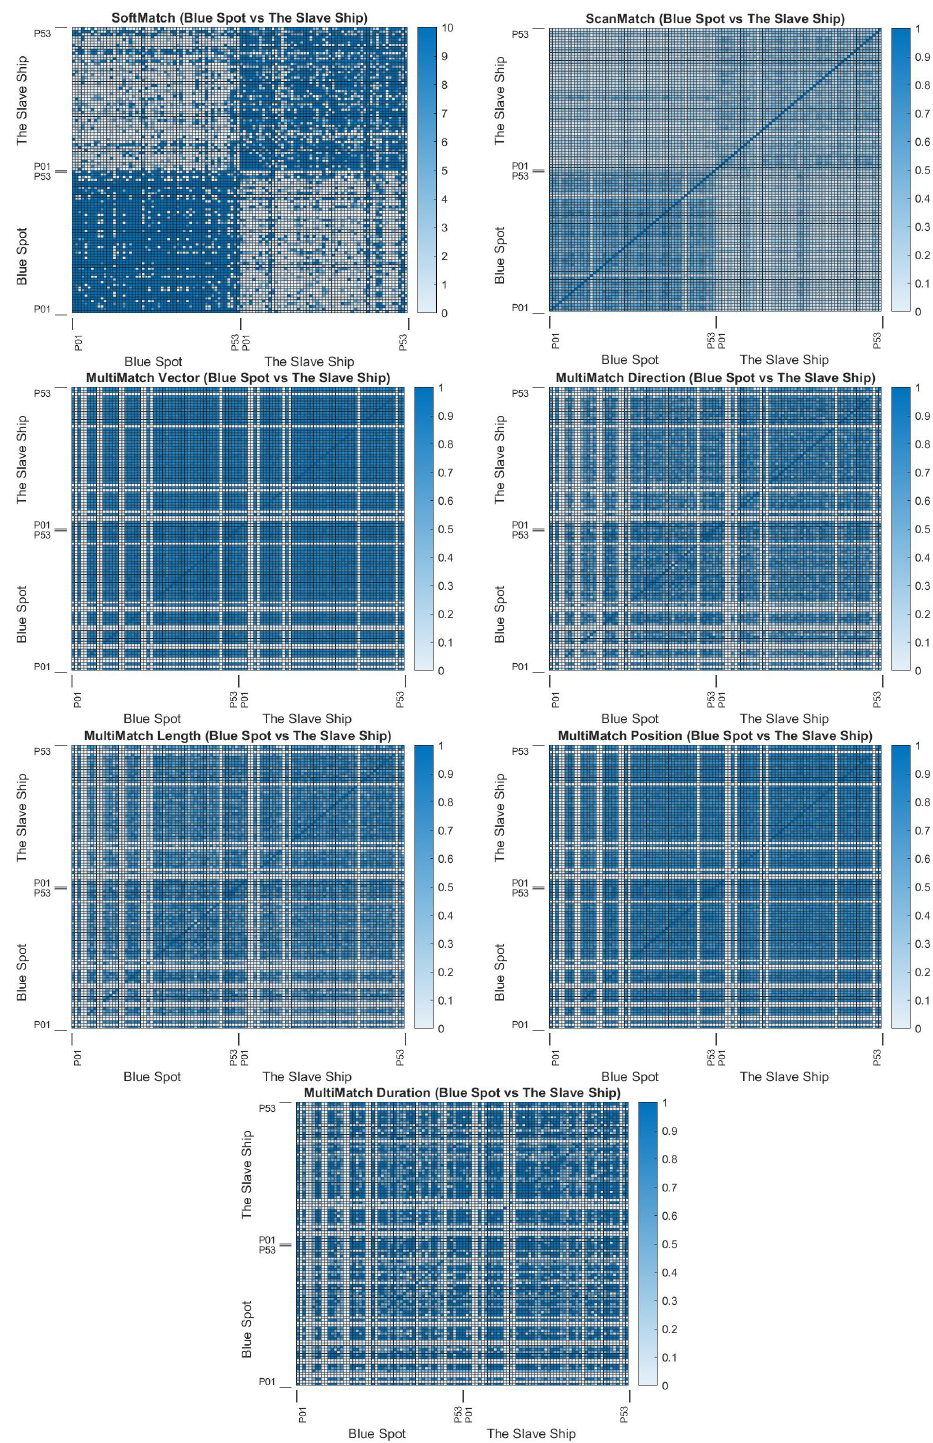
Figure A9. SoftMatch, ScanMatch, and MultiMatch heatmaps for empirical evaluation. Stimuli matched are Bernard Cohen’s Blue Spot (1966) and William Turner’s The Slave Ship